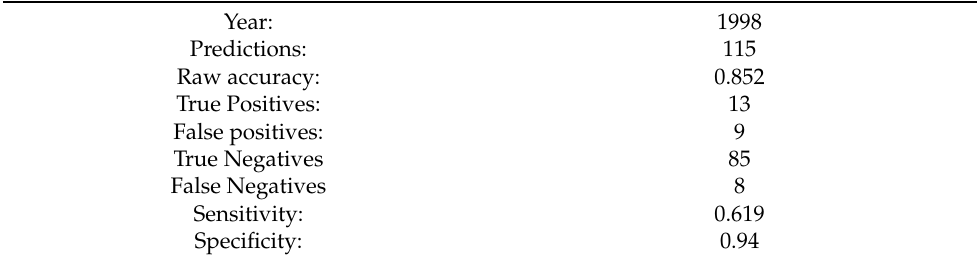
Table 4. Adaboost metrics for the target dataset.